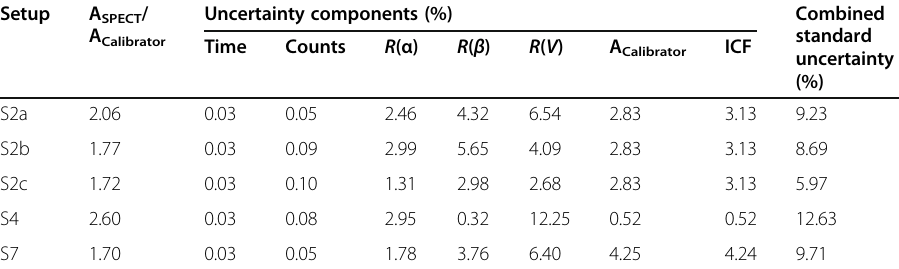
Table 5 Uncertainty budget for renal medulla activity ratios (A SPECT : SPECT-based activity, A Calibrator : radionuclide calibrator-based activity, R( α ) / R( β ) / R(V): uncertainty components introduced by the recovery originating from α , β and V,